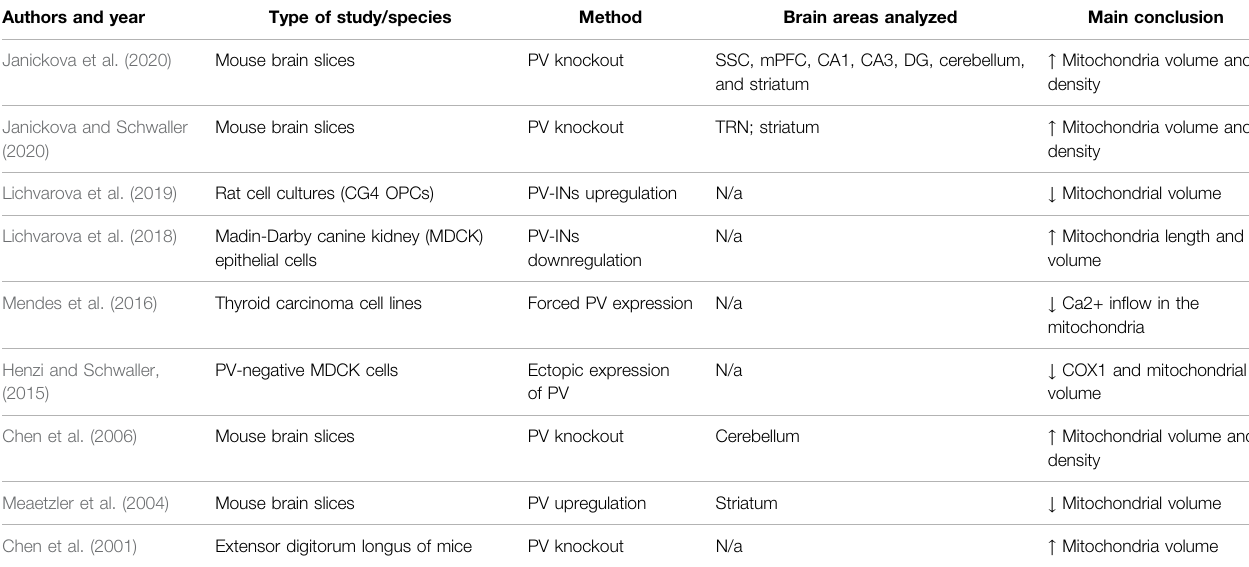
TABLE 2 | Results from systematic search on literature (PubMed) of the following keywords: Parvalbumin AND mitochondria. Only data that directly investigated the effect that parvalbumin impairments exert on mitochondria have been included, criterion assessed based on information illustrated in titles/abstracts. Authors and